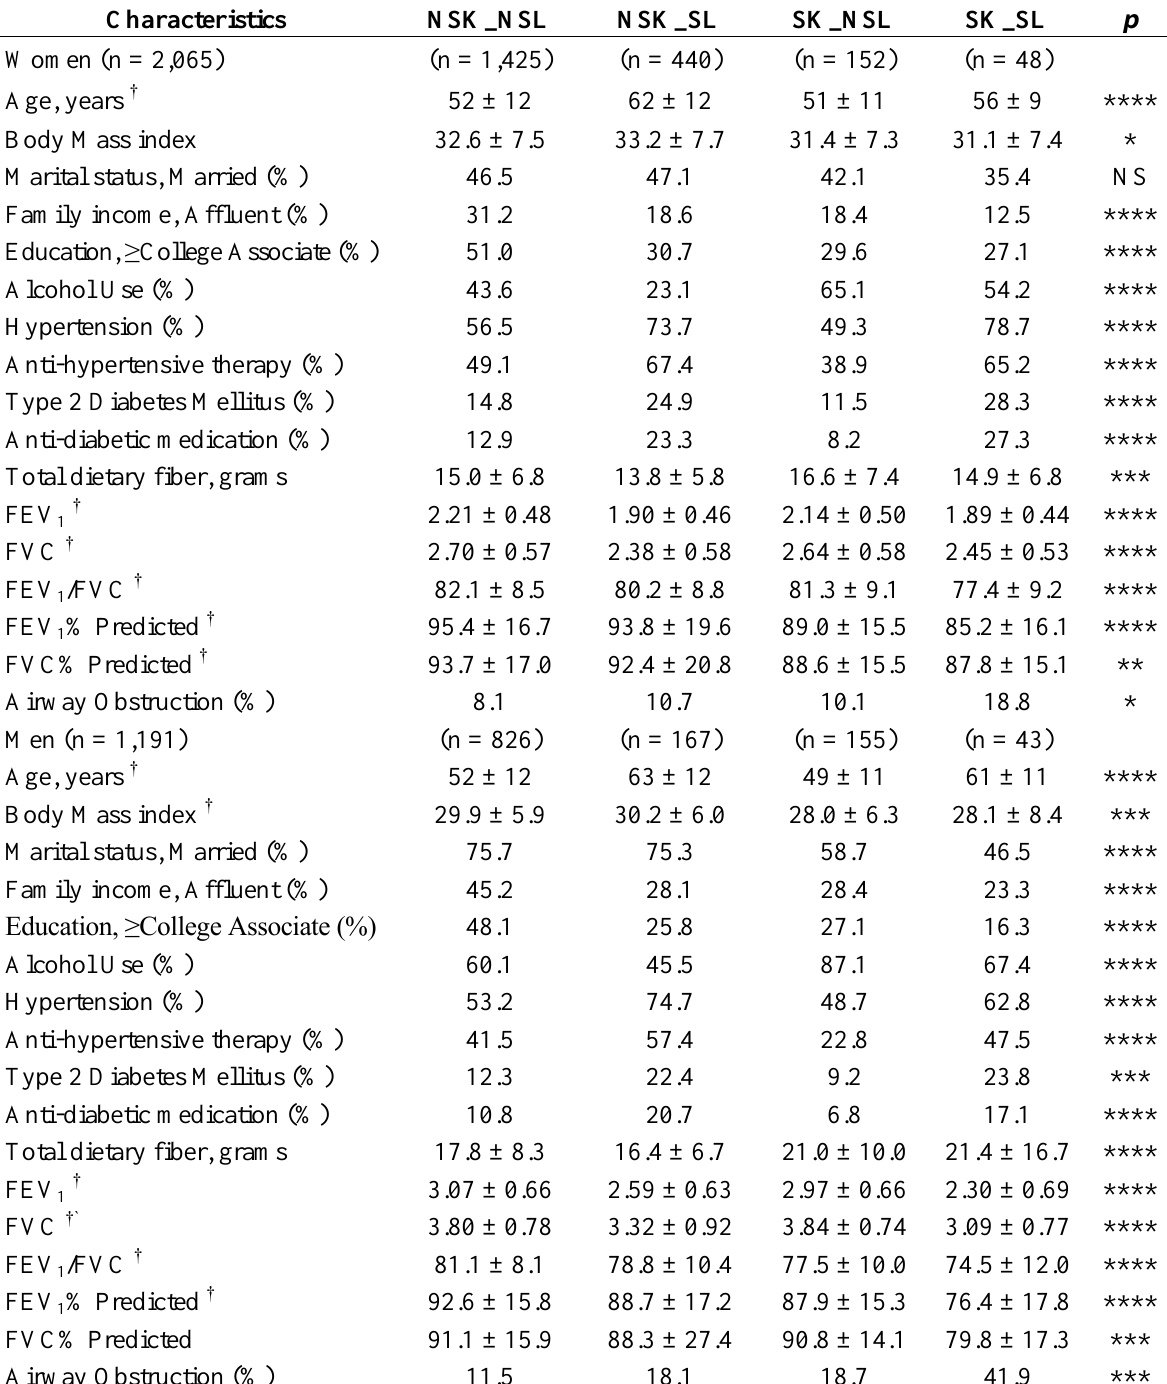
Table 1. Sex-stratified socio-demographic, lifestyle, cardiovascular, and lung function characteristics by smoking and sedentary lifestyle